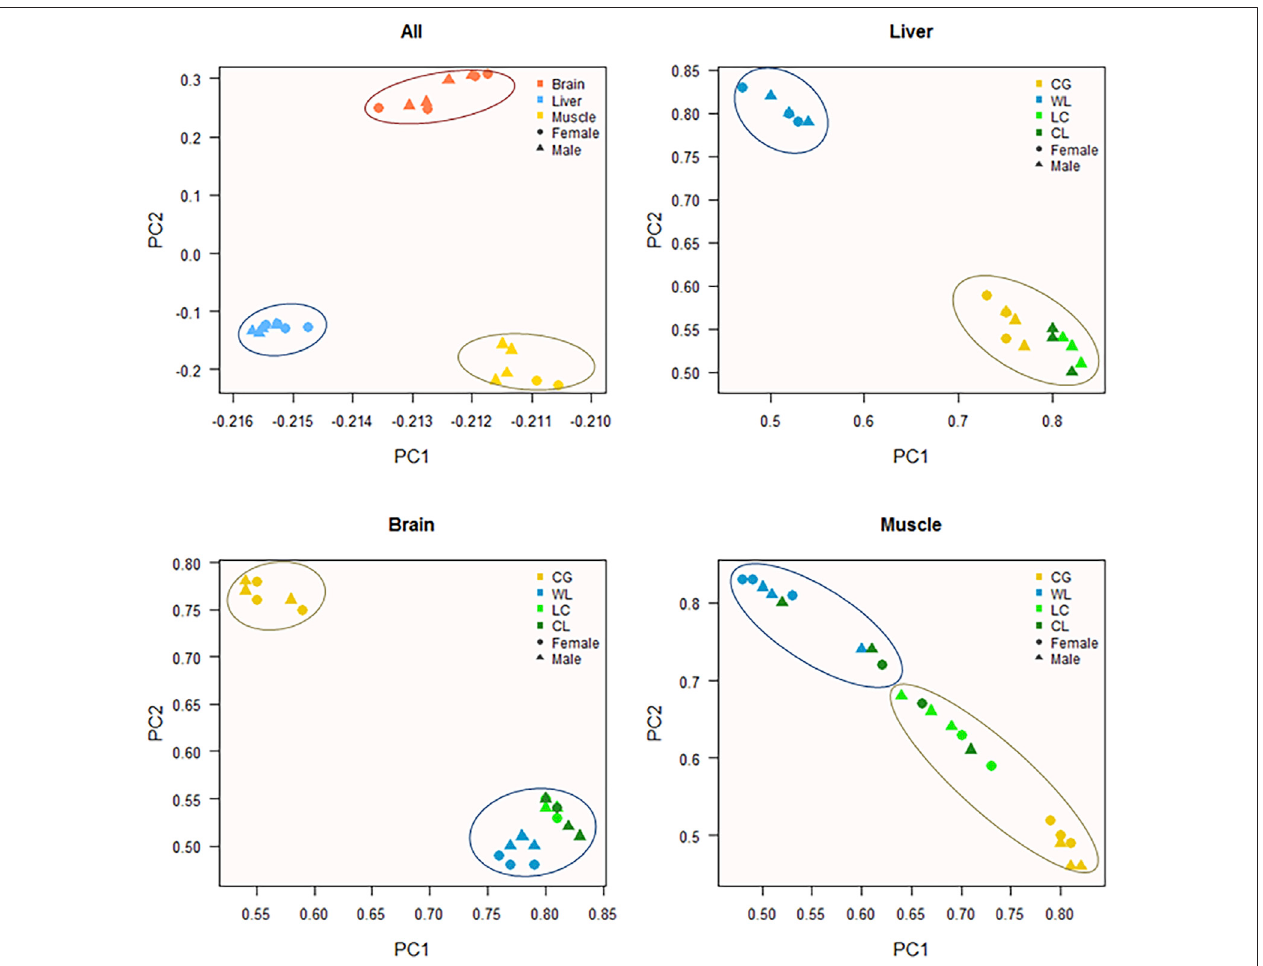
FIGURE 4 | Principal Component Analysis of alternative splicing. PCA analysis is performed using PSI value for signi fi cantly different (FDR < 0.05) AS events between purebreds, which events located on the sex chromosomes has been excluded.